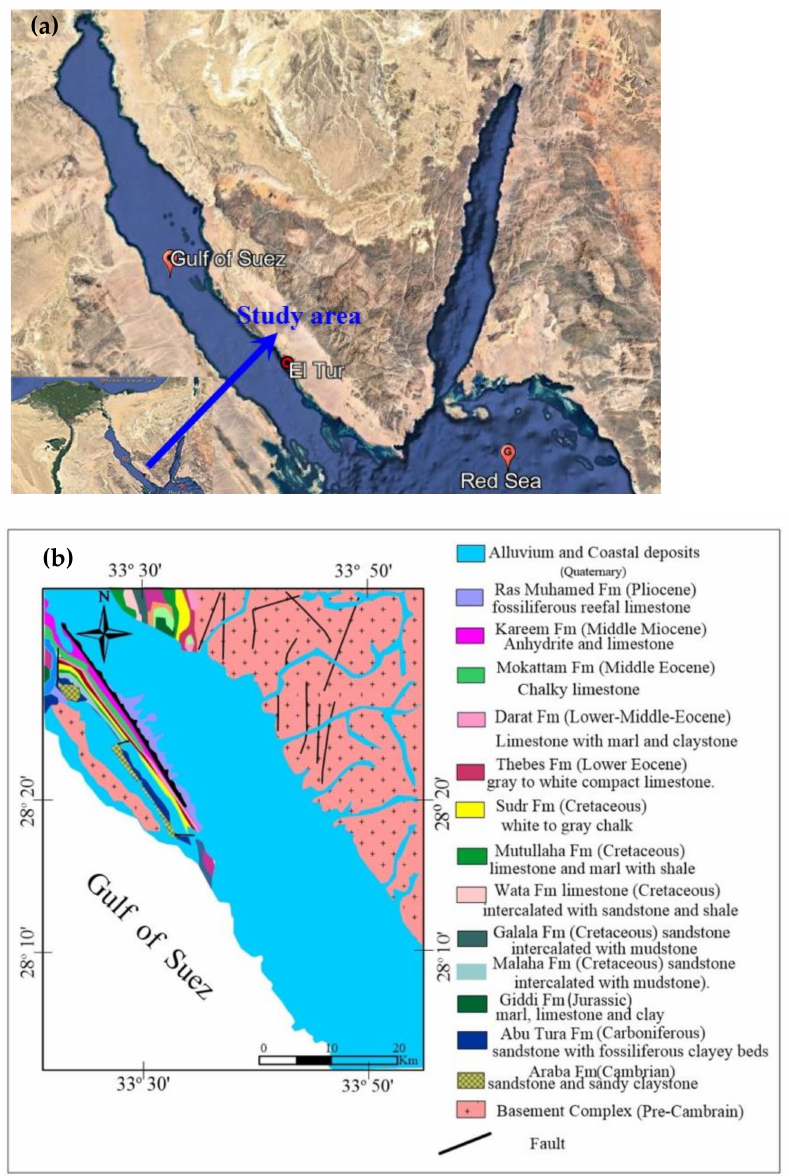
Figure 1. El-Aawag Watershed for ( a ) location map of the study area (Google earth 2022) and ( b ) geological map. (after, UNSECO 2004